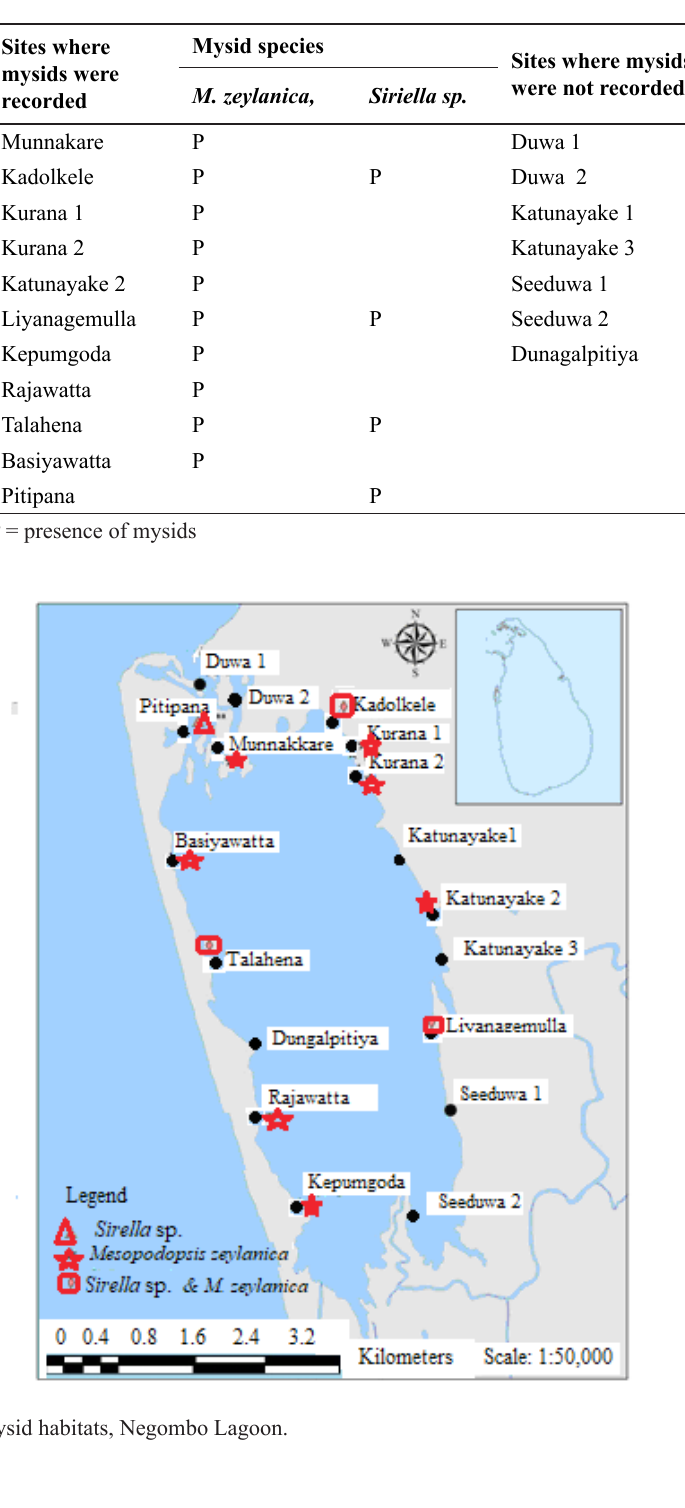
Table 2 : Distribution and of mysid species in different study sites.